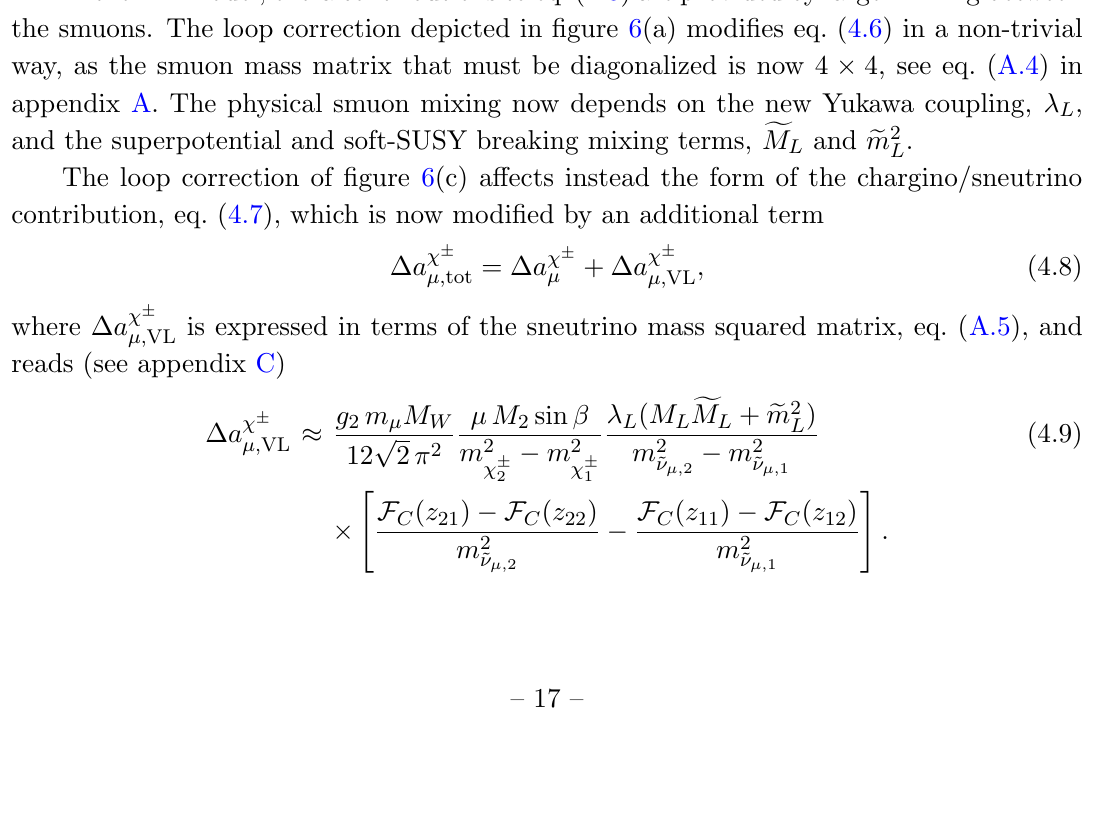
Figure 6. Main loops contributing to (cid:14) ( g one of the charged legs is implicit. We have explicitly written the doublet L as L = ( N L ; E L ) T